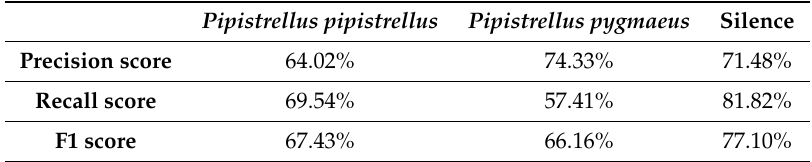
Table 1. Results of the classification model using the filter bank coefficients